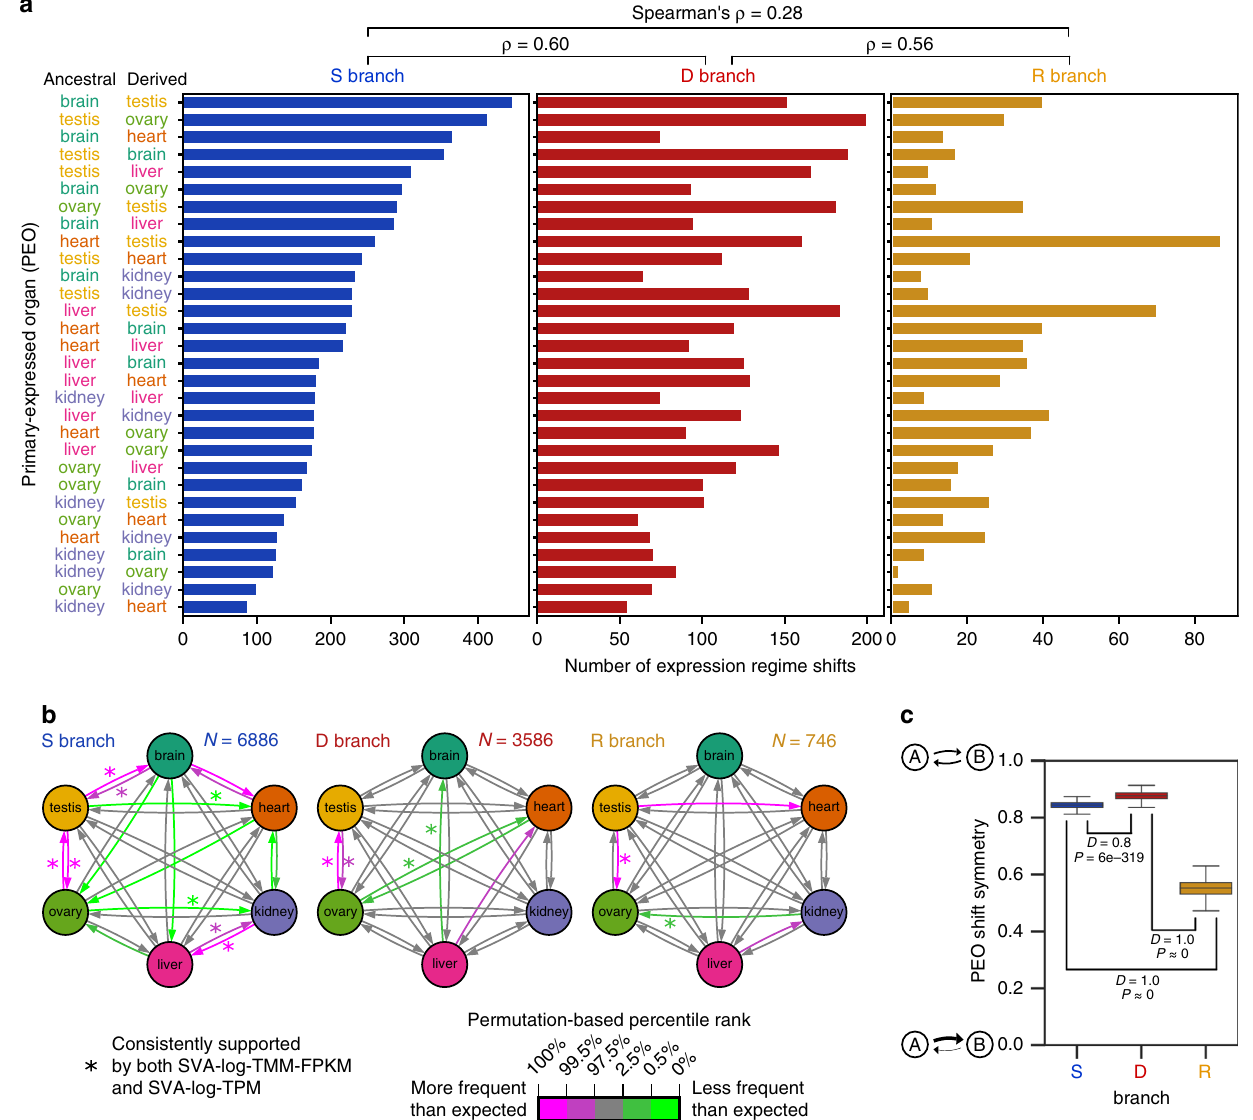
Fig. 5 Evolutionary dynamics of gene expression. a Shift distributions of primary-expressed organs (PEOs). Y -axis was sorted by abundance in S branches. Spearman ’ s correlation coef fi cients among S, D, and R branches are shown above the plots. b Preadaptation networks in organ expression. Arrows represent transitions from ancestral PEOs to derived PEOs, and its color shows statistical signi fi cance based on 10,000 permutations. The results were obtained with SVA-log-TMM-FPKM, and an asterisk (*) indicates the statistical signi fi cance supported also by SVA-log-TMM-based analysis (Supplementary Fig. 11). c The global polarity of PEO shifts. The global polarity is de fi ned by the scaled sum of differences between two opposite PEO shifts. Boxplots show the distribution estimated by 1000 bootstrap resampling. The D statistics and P values of pairwise branch category comparisons were calculated with two-sided Kolmogorov – Smirnov tests. Boxplot elements are de fi ned as follows: center line, median; box limits, upper and lower quartiles; whiskers, 1.5 × interquartile